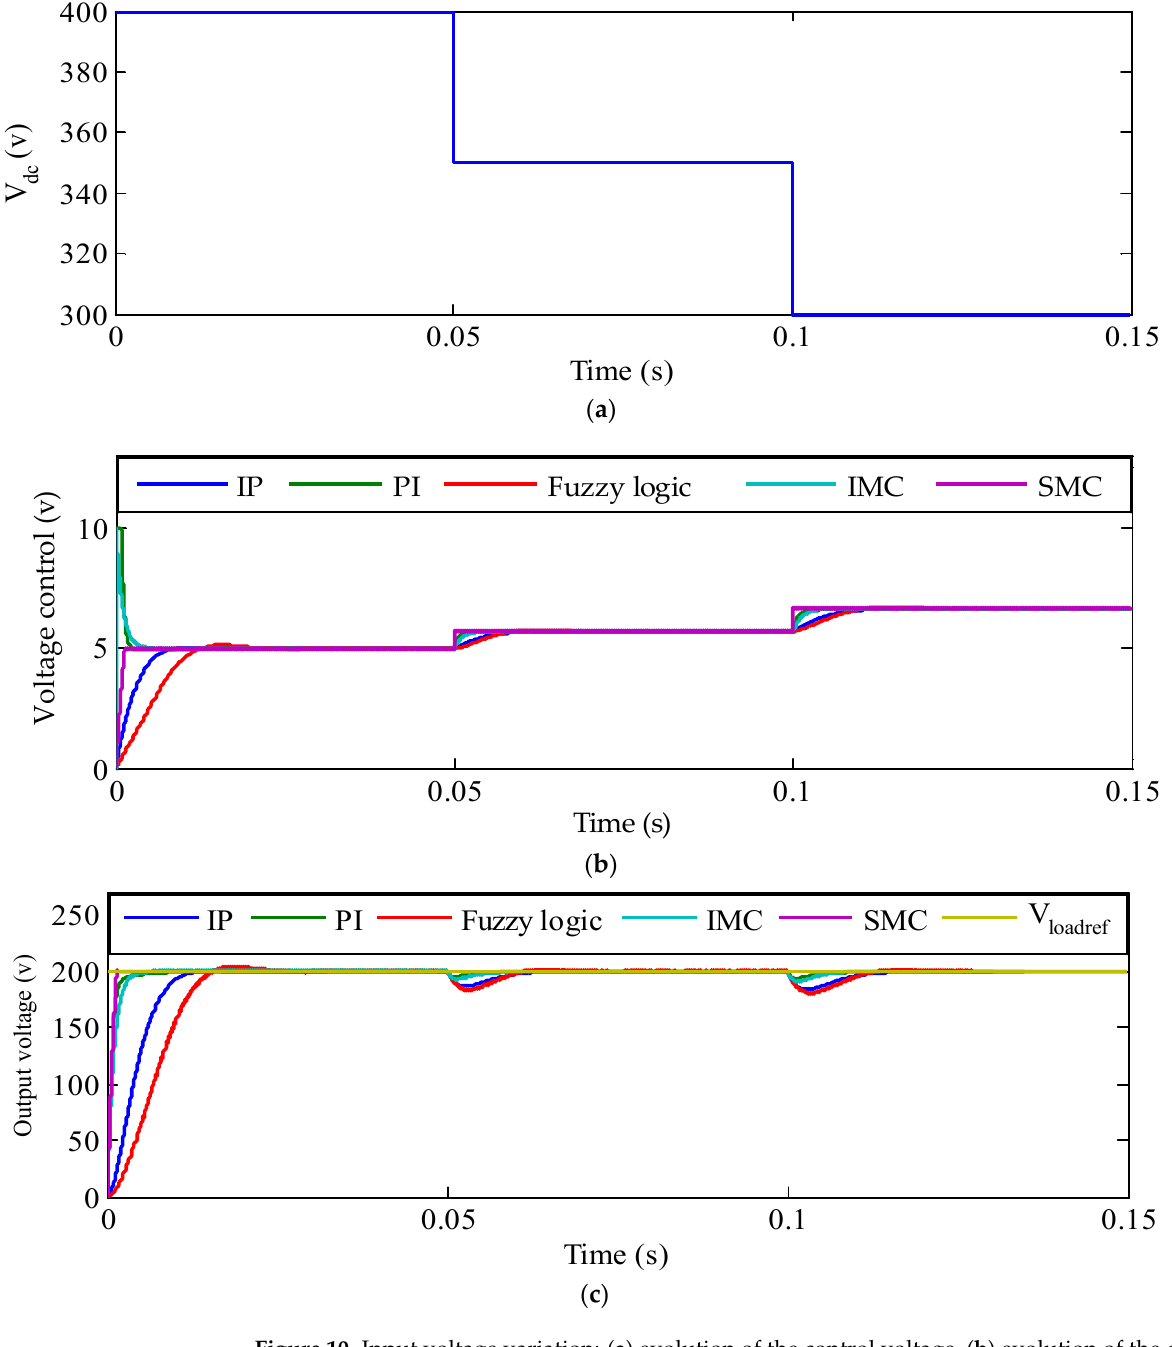
Figure 10. Input voltage variation: ( a ) evolution of the control voltage, ( b ) evolution of the control voltage and ( c ) evolution of the control voltage.